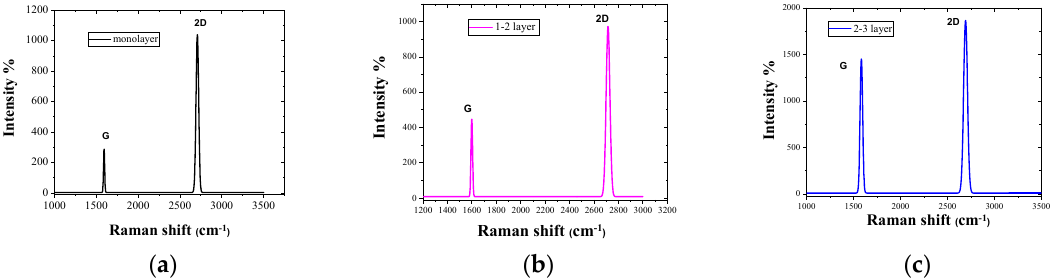
Figure 2. Raman analyses of ( a ) monolayer, ( b ) 1–2 layers, and ( c ) 2–3 layers Gr nanosheets, which were transferred onto G substrates using the CVD technique.